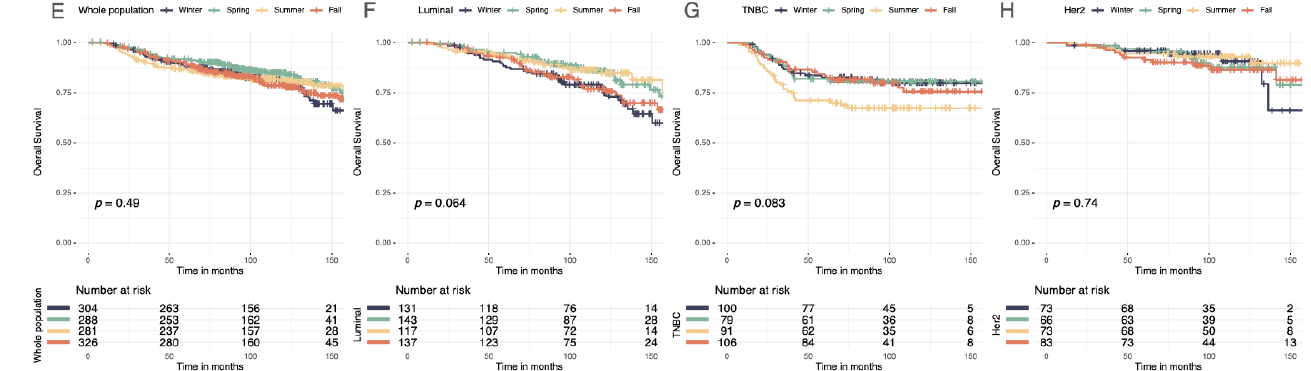
Figure 5. Relapse-free and overall Kaplan – Meier survival curves by season at BC diagnosis. ( A ) Relapse-free survival curves according to season. ( B ) Relapse-free survival curves in luminal breast cancer according to season. ( C ) Relapse-free survival curves in TNBC breast cancer according to season. ( D ) Relapse-free survival curves in Her2 -positive breast cancer according to season. ( E ) Overall survival curves according to season. ( F ) Overall survival curves in luminal breast cancer according to season. ( G ) Overall survival curves in TNBC breast cancer according to season. ( H ) Overall survival curves in Her2 -positive breast cancer according to season.